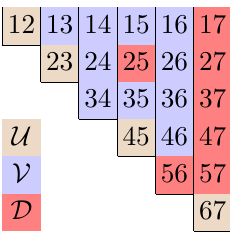
Figure 5. Color-coded matrix displaying the choice of Mellin variable index subsets U 7 , mix , V 7 , mix and D 7 , mix